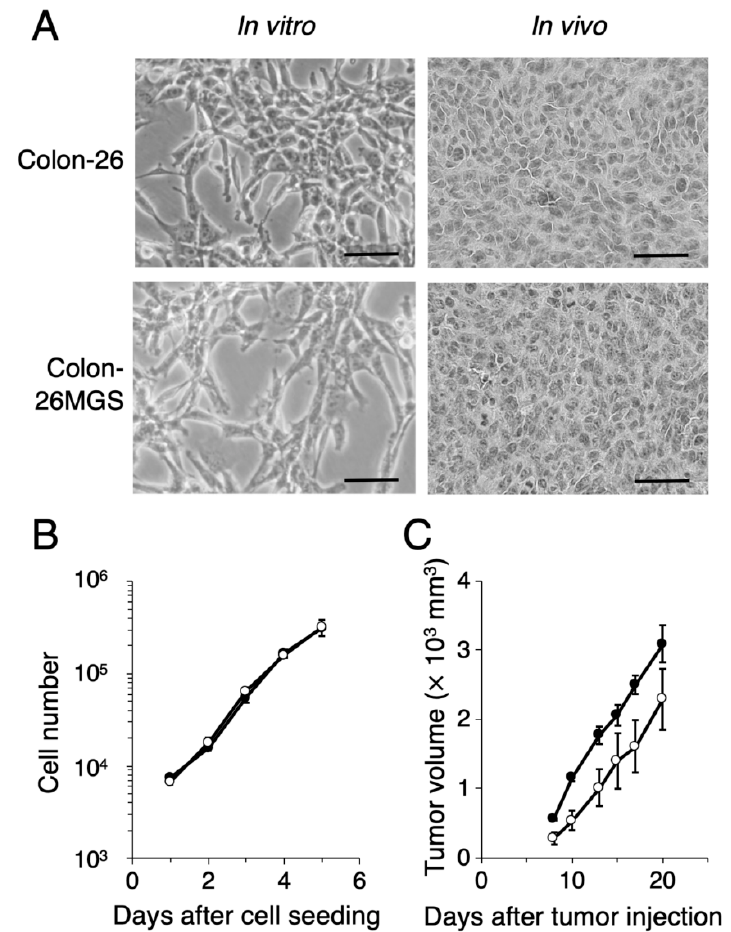
Figure A1. Phenotypic characterization of a novel highly metastatic cancer cell line Colon-26MGS. ( A ) In vitro and in vivo tumor cell morphology (scale bar: 50 μ m). ( B ) In vitro cancer cell and ( C ) in vivo primary tumor cell proliferation of Colon-26 (closed circles) and Colon-26MGS (open circles). Bars indicate standard error calculated using data from three independent trials.